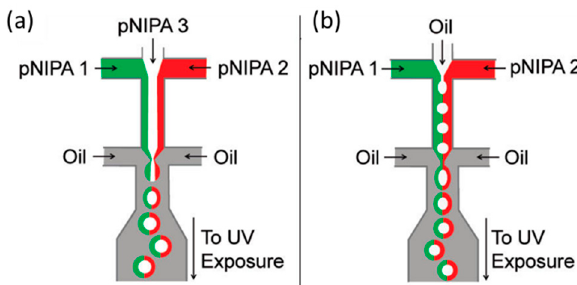
Figure 12. Formation of Janus microgels and microshells [125]. ( a ) Schematic of a microfluidic device forming aqueous droplets from three independent semidilute pNIPPAm solutions. The center phase (white) is assembled in the core of the droplets, whereas the right- and left-flowing phases (red and green) form the shell ( b ) operating the device in a modified way yields oil-water-oil double emulsions with Janus-shaped middle phases. Reproduced with permission from Seiffert, S., et al., Langmuir ; published by American Chemical Society, 2010.